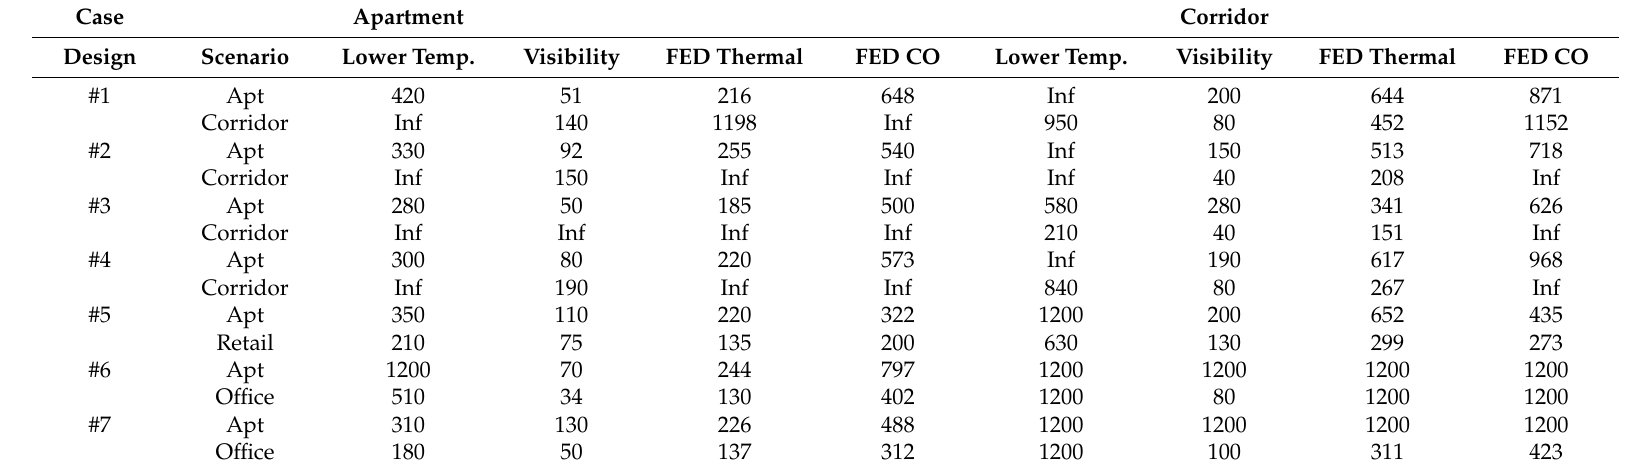
Table 9. B-Risk ASET results based on Trial Design